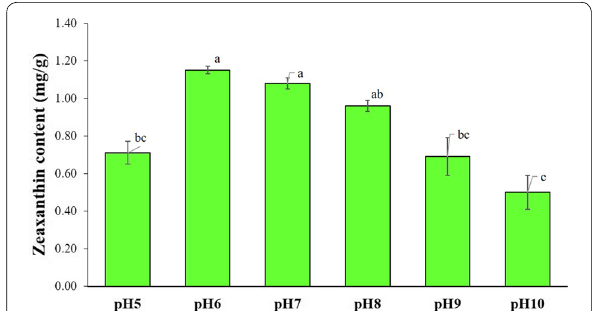
Fig. 5 Effect of different culture pH the zeaxanthin accumulation by A. gandavensis MTCC 25325 after 72 h. All statistical significance comparisons between indicated groups were performed using a one-way ANOVA with Fisher’s post-test. Data presented are mean values and their standard deviation